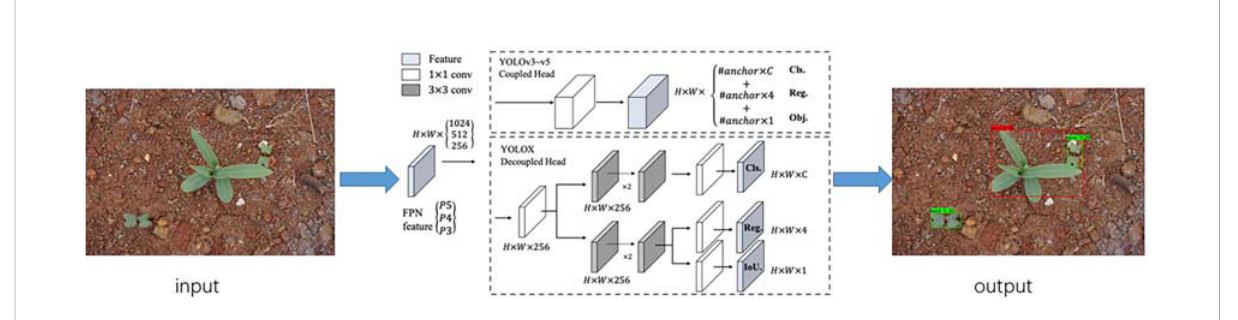
FIGURE 6 YOLOX maize seedling and weed detection